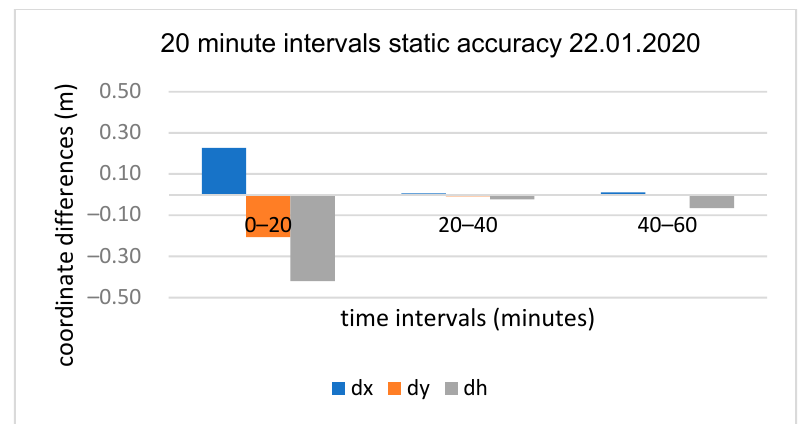
Figure 12. 15 min sub-session positioning results for the second test, baseline OPNT–P30Pro (4km).